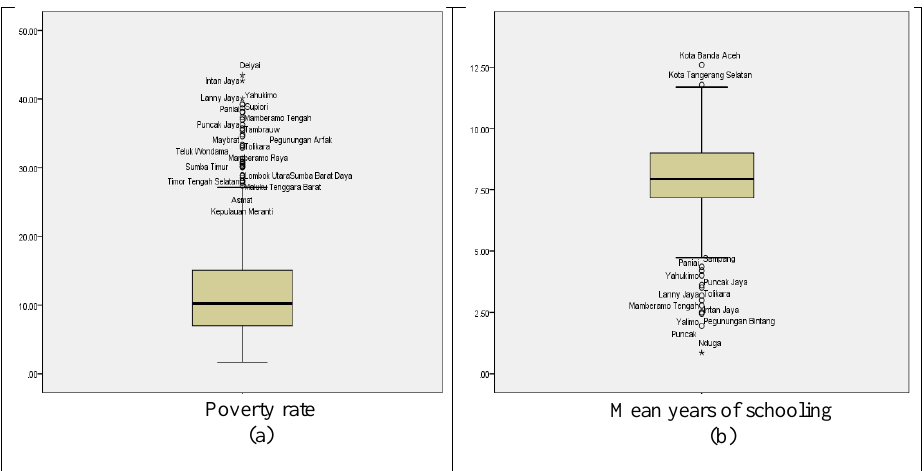
Fig. 2. Boxplot of (a) poverty rate, (b) mean years of schooling by